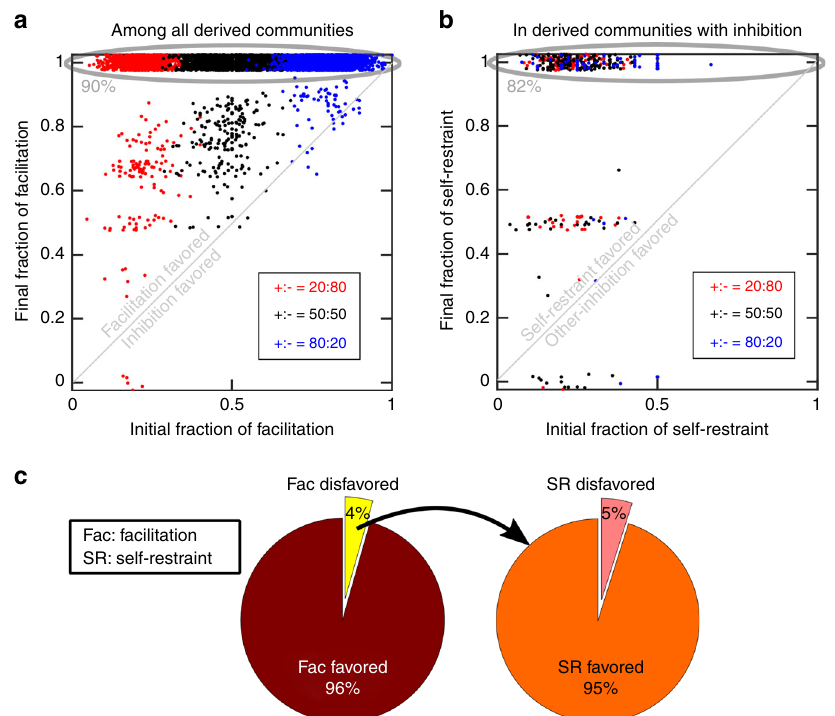
Fig. 4 Facilitation and self-restraint are favored in enrichment. We examined how the fraction of interaction types changed from the initial pool to the fi nal derived community. Each dot here represents an enrichment process going from 20 initial species to a fi nal community with at least two coexistent species. We examined three conditions with the initial ratio of facilitation to inhibition in fl uences being 20:80 (red), 50:50 (black), or 80:20 (blue). a Facilitation was highly favored (i.e., its frequency increased from the initial pool to the derived communities), and 90% of derived communities contained only facilitation. b In fi nal communities that contained inhibition, self-restraint was prevalent (82% in this category contained only self-restraint), even though the fraction of self-restraint was only 20 ± 11% (s.d.) in the initial pool. Points above the diagonal line represent that facilitation and self-restraint are favored in ( a ) and ( b ), respectively. Fractions in derived communities appear quantized (especially in ( b )) due to the small numbers of in fl uences remaining (1 out of 1, 1 out of 2, 2 out of 2, 1 out of 3, etc.). The data points in ( a ) and ( b ) are jittered by 5% to reduce overlap for visualization purposes. c We examined the break-down of different categories of in fl uences. Facilitation was favored in 96% of communities during enrichment, including in all communities that lacked self-restraint. Among the 4% in which facilitation was disfavored, in 95% of cases self-restraint was favored during enrichment. This suggests that facilitation is the main driver of coexistence, with self-restraint being a secondary means of achieving coexistence. In these simulations, the number of initial pools examined N s = 30,000, the initial number of species types N c = 20, and the number of possible mediators N m = 15.